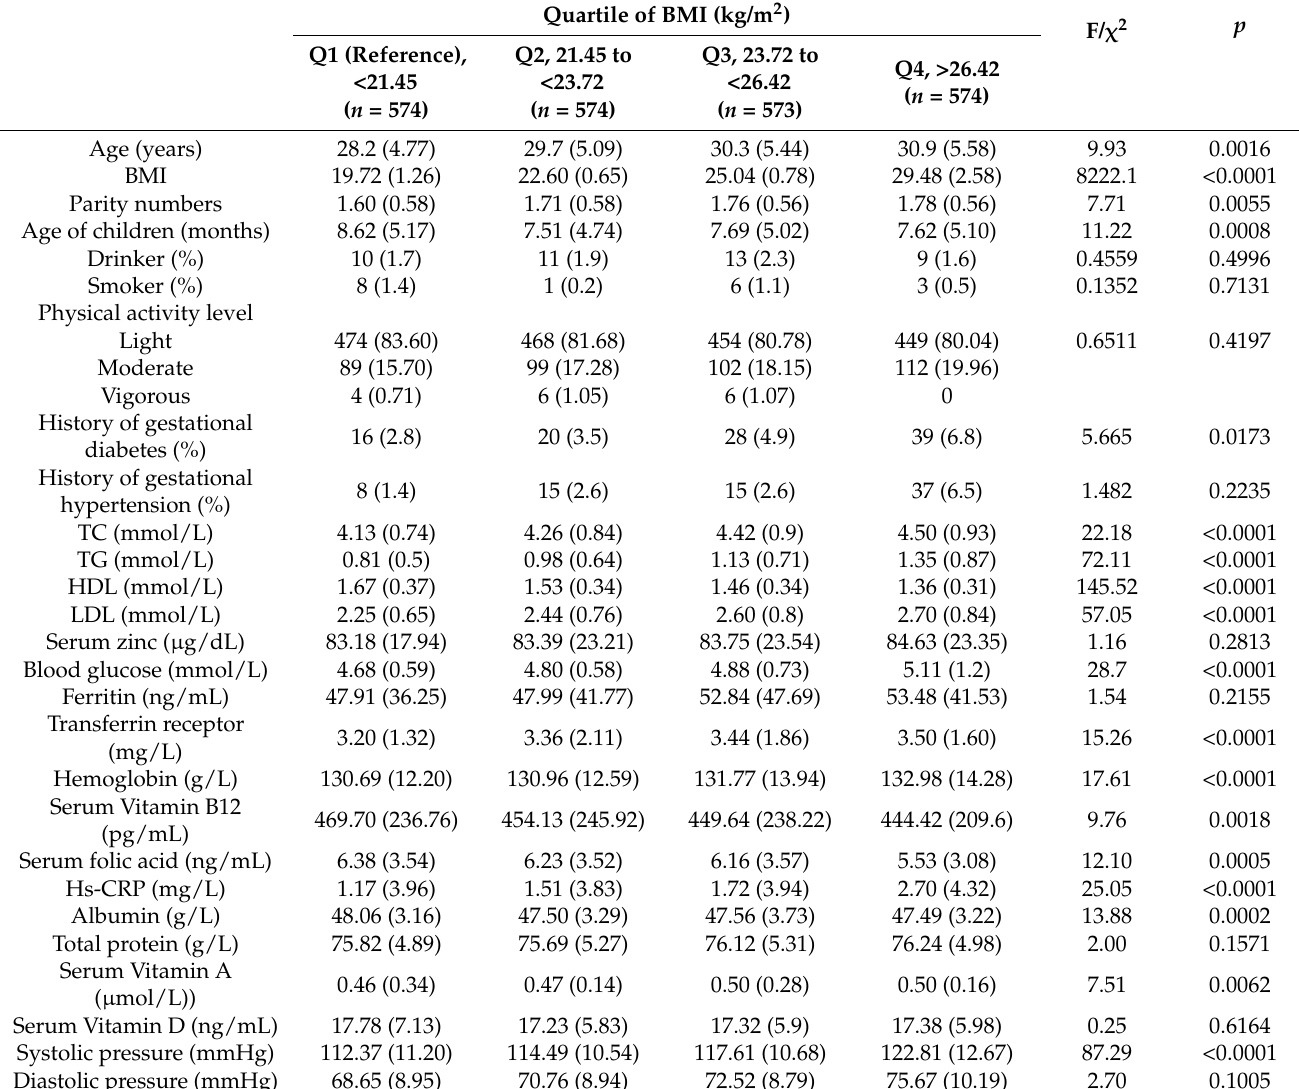
Table 1. Characteristics by BMI quartile in lactating women.